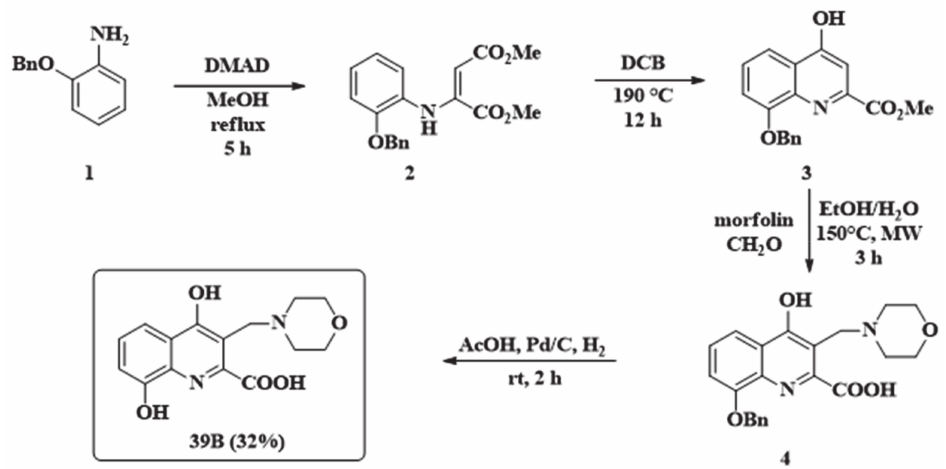
Figure 3. Synthesis of morpholinomethylated xanthurenic acid 39B